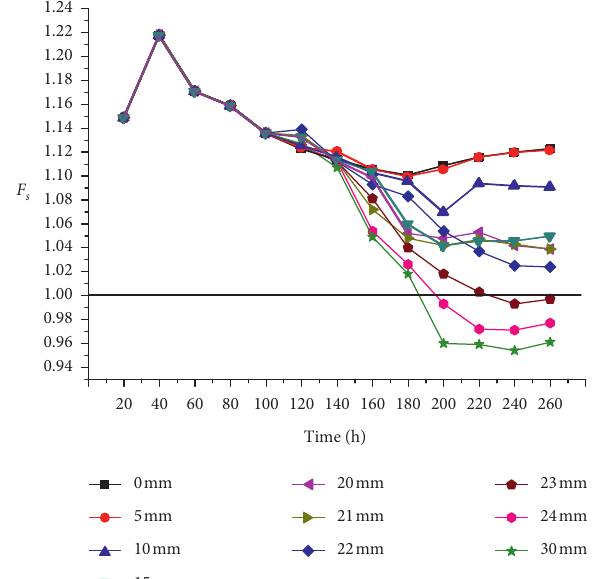
Figure 16: The relationship curve between stability coefficient and time, under different infiltration